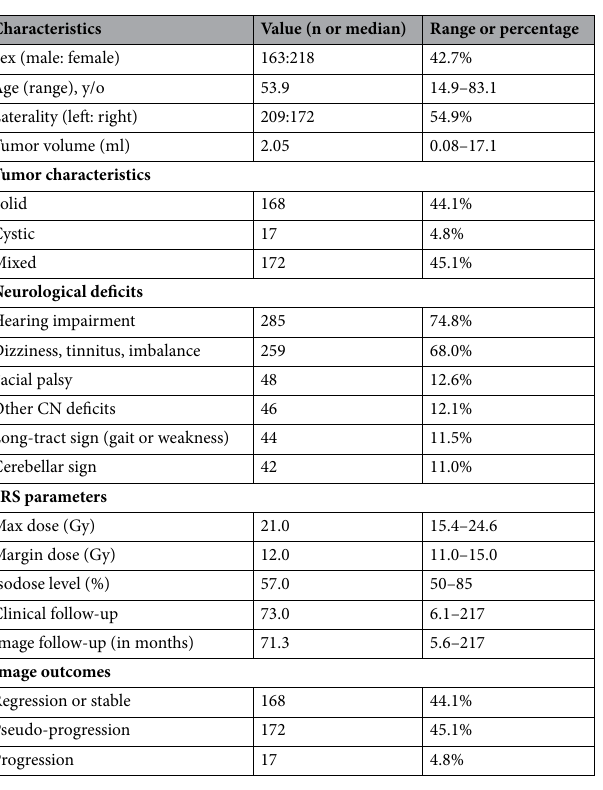
Table 1. Demographic characteristics of 381 patients with vestibular